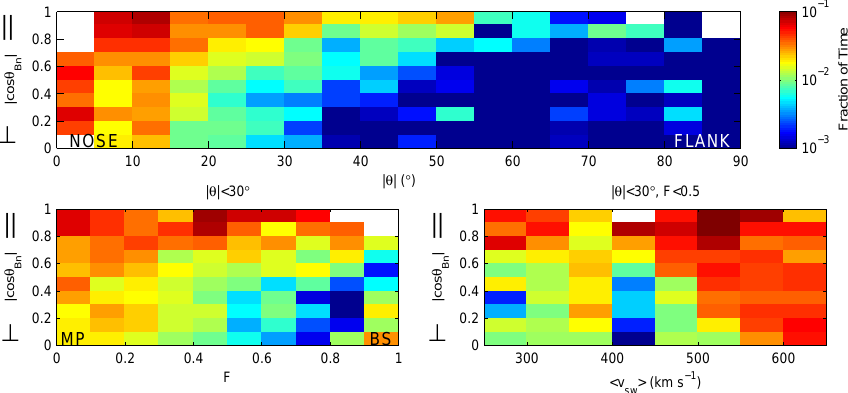
Fig. 2. Bivariate histograms where the logarithmic colour scale represents the fraction of the time that dynamic pressure enhancements ( δP dyn / (cid:10) P dyn (cid:11) > 1) are observed. All panels show the absolute cosine of the magnetic field – shock normal angle | cos θ Bn | along the vertical. Across the horizontal (top) are the aberrated solar zenith angle | θ | ; bottom left: magnetosheath fractional distance F shown for the subsolar ( | θ | < 30 ◦ ) case; and bottom right: solar wind speed for the subsolar inner ( | θ | < 30 ◦ and F < 0 . 5) magnetosheath. White areas indicate poor coverage from the magnetosheath